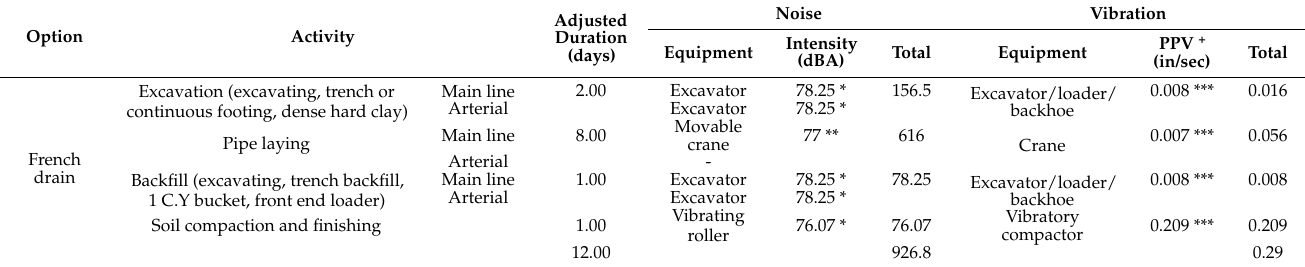
Table 11. Like the technical and quality scores, the social/environmental scores were scaled